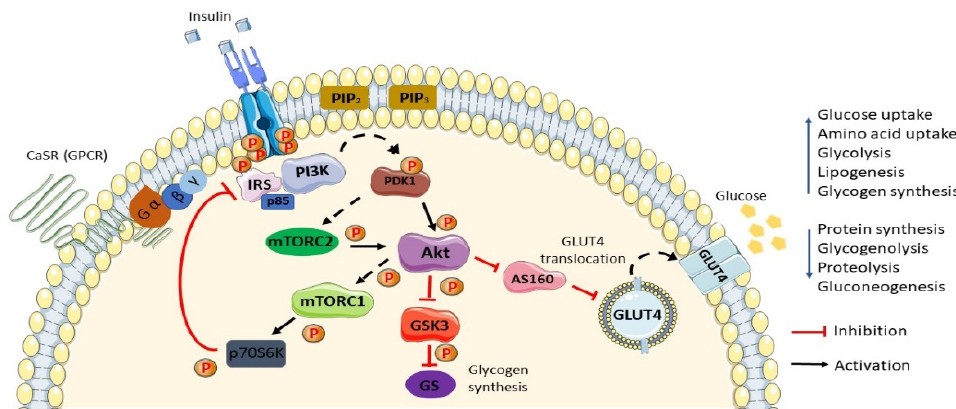
Figure 1. Schematic diagram of the general insulin signaling pathway in cells mediated through IR/RTK. The phosphorylation of RTK recruits various downstream regulatory proteins. The insulin signal is transduced among the target proteins/enzymes until GLUT4 vesicle fusion with the plasma membrane of the cell: CaSR, calcium-sensing receptor; IRS, insulin receptor substrate; p85, phospho-PI3 kinase p85 ; PI3K, phosphoinositide 3-kinases; PIP2, phosphatidylinositol 4,5-bisphosphate; PIP3, phosphatidylinositol 3,4,5-bisphosphate; PDK1, phosphoinositide-dependent protein kinase-1; mTORC (1/2), mammalian/mechanistic target of rapamycin complex (1/2); Akt, protein kinase B; AS160, Akt substrate of 160 kDa; GLUT4, glucose transporter 4; GSK3, glycogen synthase kinase; GS, glycogen synthase; p70S6K, ribosomal protein S6 kinase beta-1 (S6K1); P, phosphate. Phosphorylation activation (black arrow). Phosphorylation inhibition (red